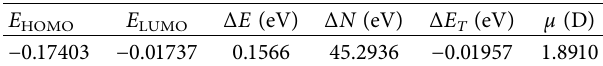
Figure 8: Optimized structure of ACM with the B3LYP/6-31G (d, p). Table 8: Molecular properties of ACM calculated using DFTat the B3LYP/6-31G (d, p) basis set.